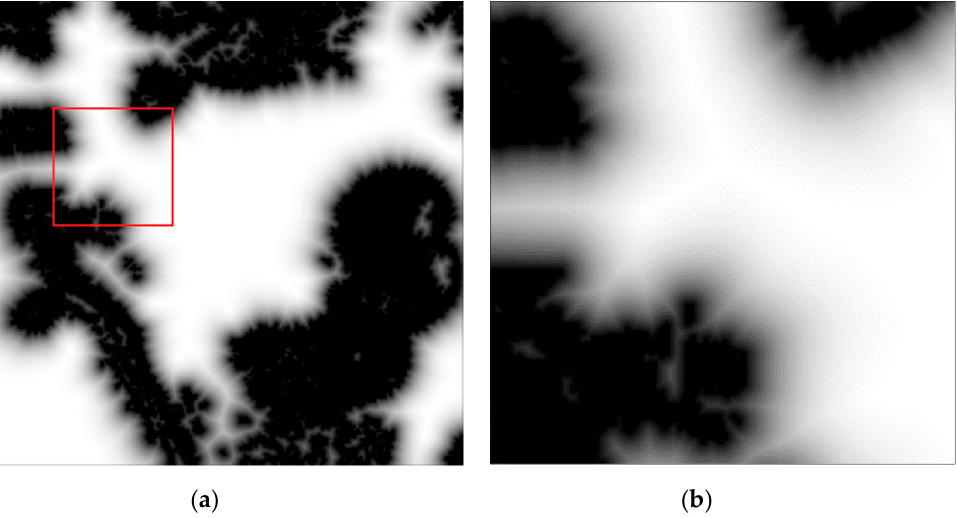
Figure 7. Schematic diagram of the open space. ( a ) is the obstacle cost map of cutting zone; ( b ) is the open space area in the red square in ( a ).